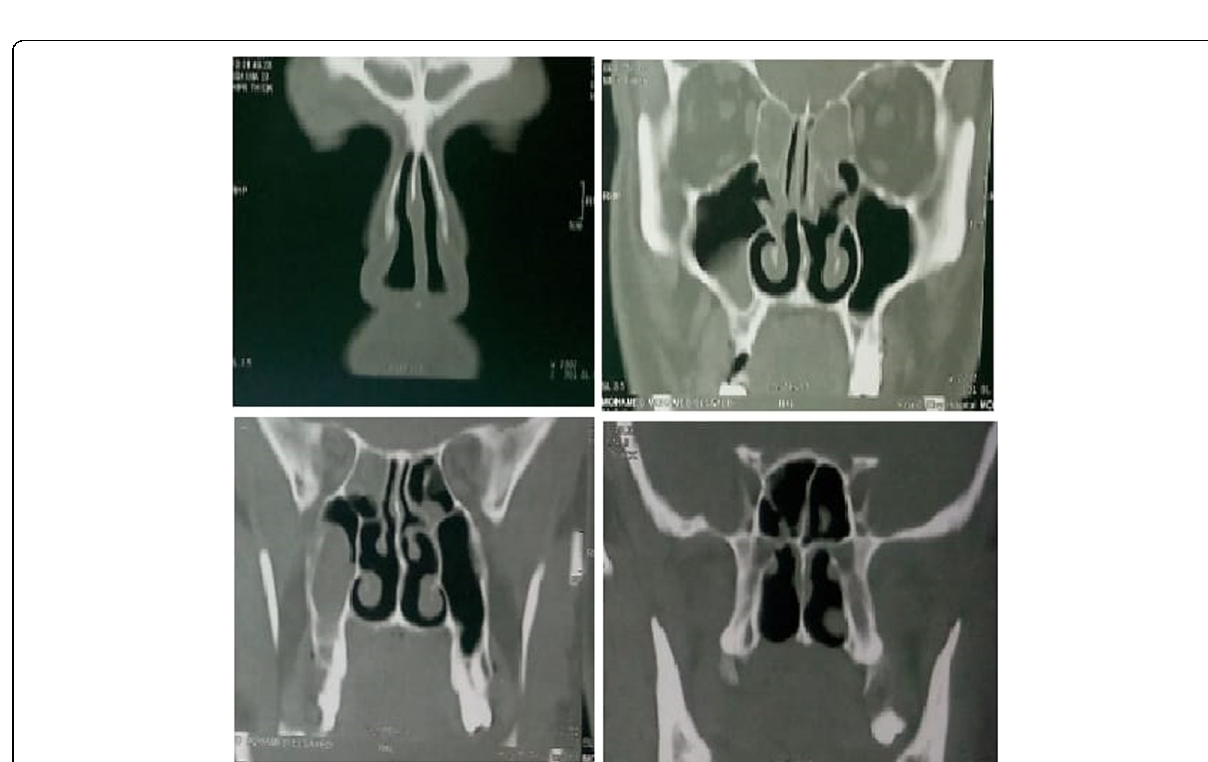
Fig. 12 CT PNS of the same patient after oral steroid, showing partial